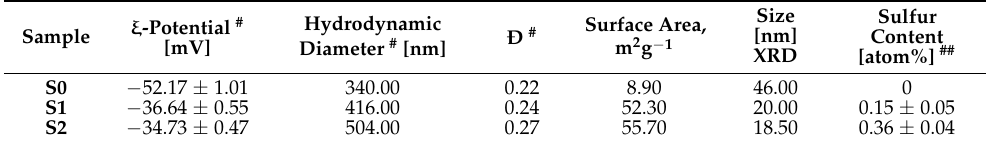
Table 1. Catalyst particle